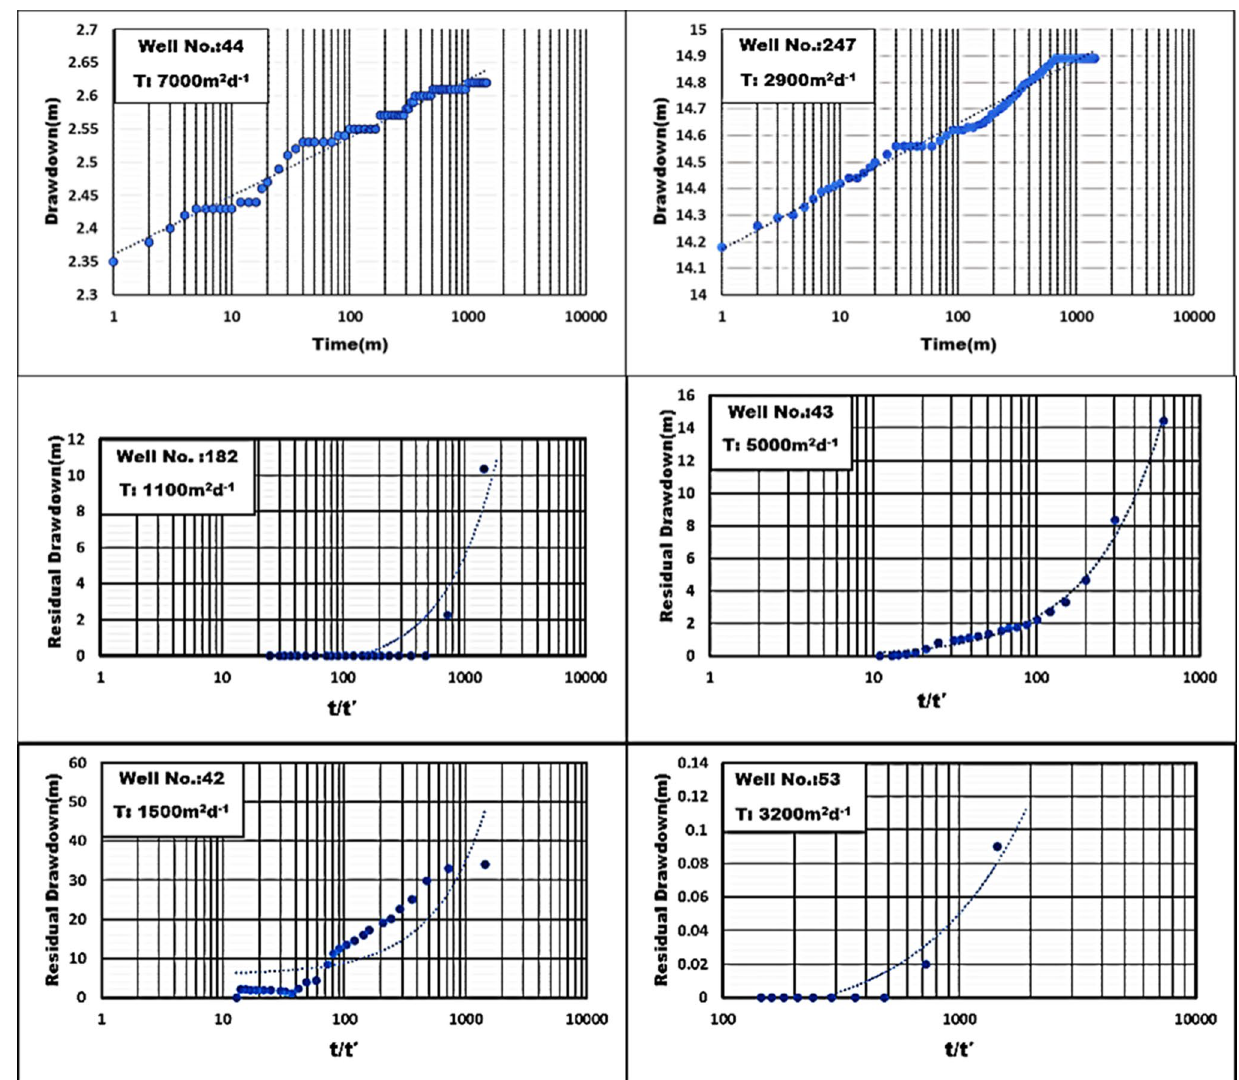
Fig. 12 Constructed curves of constant discharge pumping and recovery tests for the Eocene aquifer, West–West Minya,